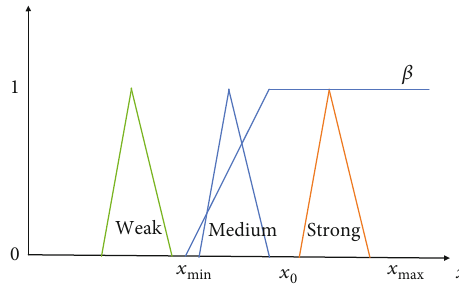
Figure 4: Classi fi cation of linguistic variable Π